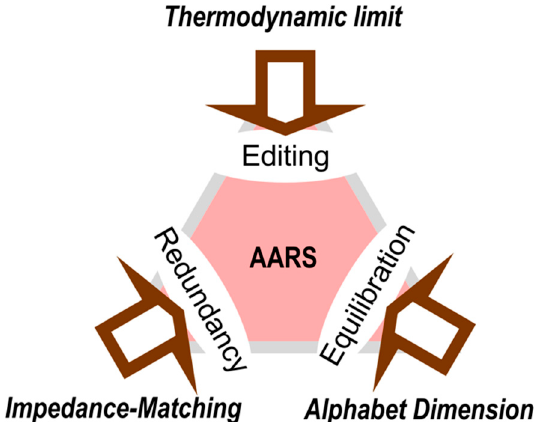
Figure 5. Simultaneous constraints on the precision of aminoacylation by aaRS. The alphabet size and fundamental thermodynamics both place different irreducible limits on aaRS precision. Any change in the dimension of the genetic coding alphabet must be followed by a round of equilibration, as new possibilities are introduced to optimize the catalytic and specificity of the extant aaRSs. Finally, minimizing the dissipation of information similarly constrains optimal aaRS precision according to the frequency of replication and transcription errors, in large part because of changes in coding redundancy